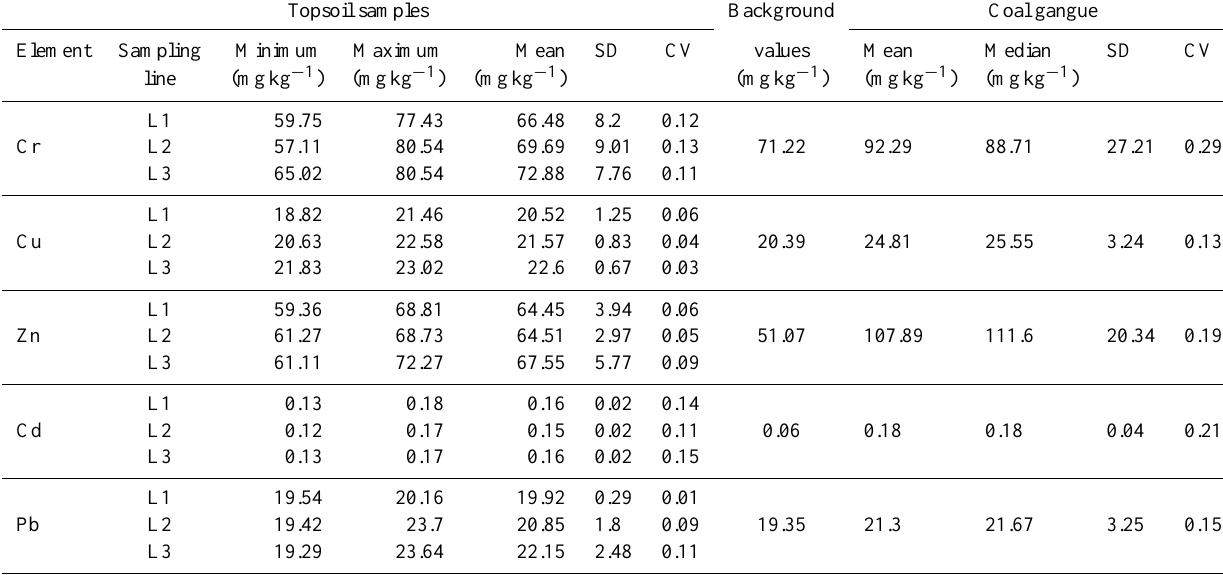
Table 2. The statistical analysis of heavy metals in topsoil samples, the background values and coal gangue samples. Topsoil samples Background Coal gangue Element Sampling Minimum